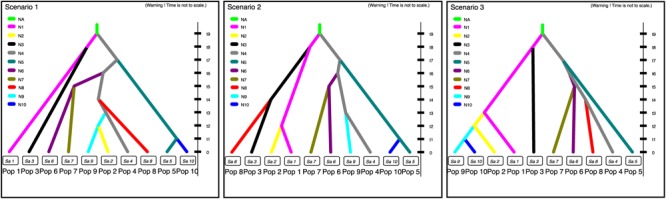
Three putative dissemination routes of cultivated P. pyrifolia in East Asia. Scenario 1 assumes that cultivated P. pyrifolia from southwestern regions (SC and YN) and Middle-Yangtze valley areas (HHJ) were diverged firstly, and then further spread from HHJ to southern (FJ and GG), eastern (AJ and ZJ) and northern areas (SS, GQ, SHH, and JL); Scenario 2 assumes that cultivated P. pyrifolia in northwestern (GQ) and southern areas (FJ and GG) were directly disseminated from southwestern populations (SC and YN); Scenario 3 assumes that cultivated P. pyrifolia from northwestern population (GQ) were initially disseminated from southwestern populations (SC and YN), from which cultivars were further spread to northern areas (SS, SHH and JL). Pop 1, YN+SC; Pop 2, GQ; Pop 3, GZ; Pop 4, HHJ; Pop 5, AJ; Pop 6, ZJ; Pop 7, JPa+JPb; Pop 8, FJ+GG; Pop 9, SS; and Pop 10, SHH+JL. The three scenarios represent the three historical models constructed based on approximate Bayesian computation, describing how the sampled populations are connected to their common ancestor. N1, N2, N3, N4, N5, N6, N7, N8, N9, and N10 represent the effective population sizes of Pop 1, Pop 2, Pop 3, Pop 4, Pop 5, Pop 6, Pop 7, Pop 8, Pop 9, and Pop 10, respectively. NA corresponds to a discrete change in the effective population size. The time is set as t9 > t8 > t7 > t6 > t5 > t4 > t3 > t2 > t1.